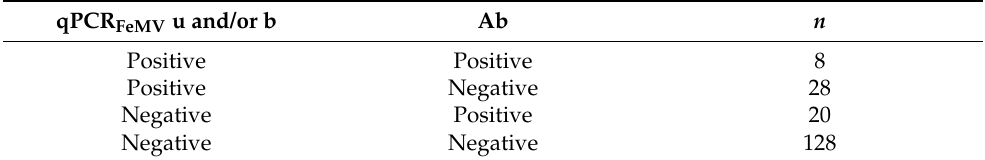
Table 9. List of the four infection patterns obtained testing with molecular (qPCR FeMV u and/or b) and serological (Ab) assays related to FeMV and number ( n ) of cats showing any single pattern. qPCR FeMV u and/or b Ab n Positive Positive 8